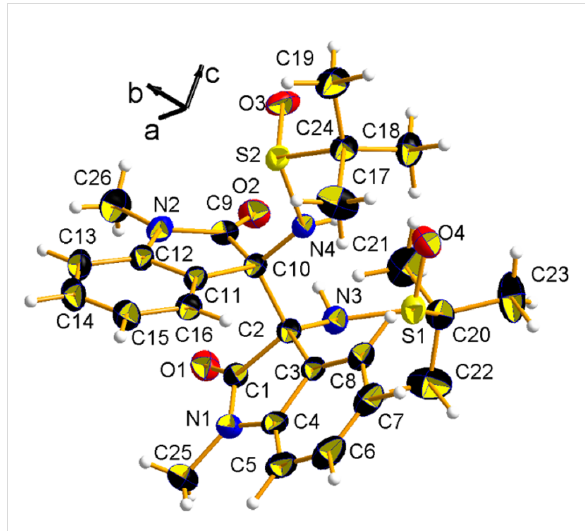
Figure 1: Asymmetric unit of 2a , with the atom-numbering scheme. The crystallographic reference system is also shown. Thermal ellip- soids at rt were drawn at the 50% probability level. Atoms are repre- sented with the usual colour code (C: black; N: blue; O: red; S: yellow; H: